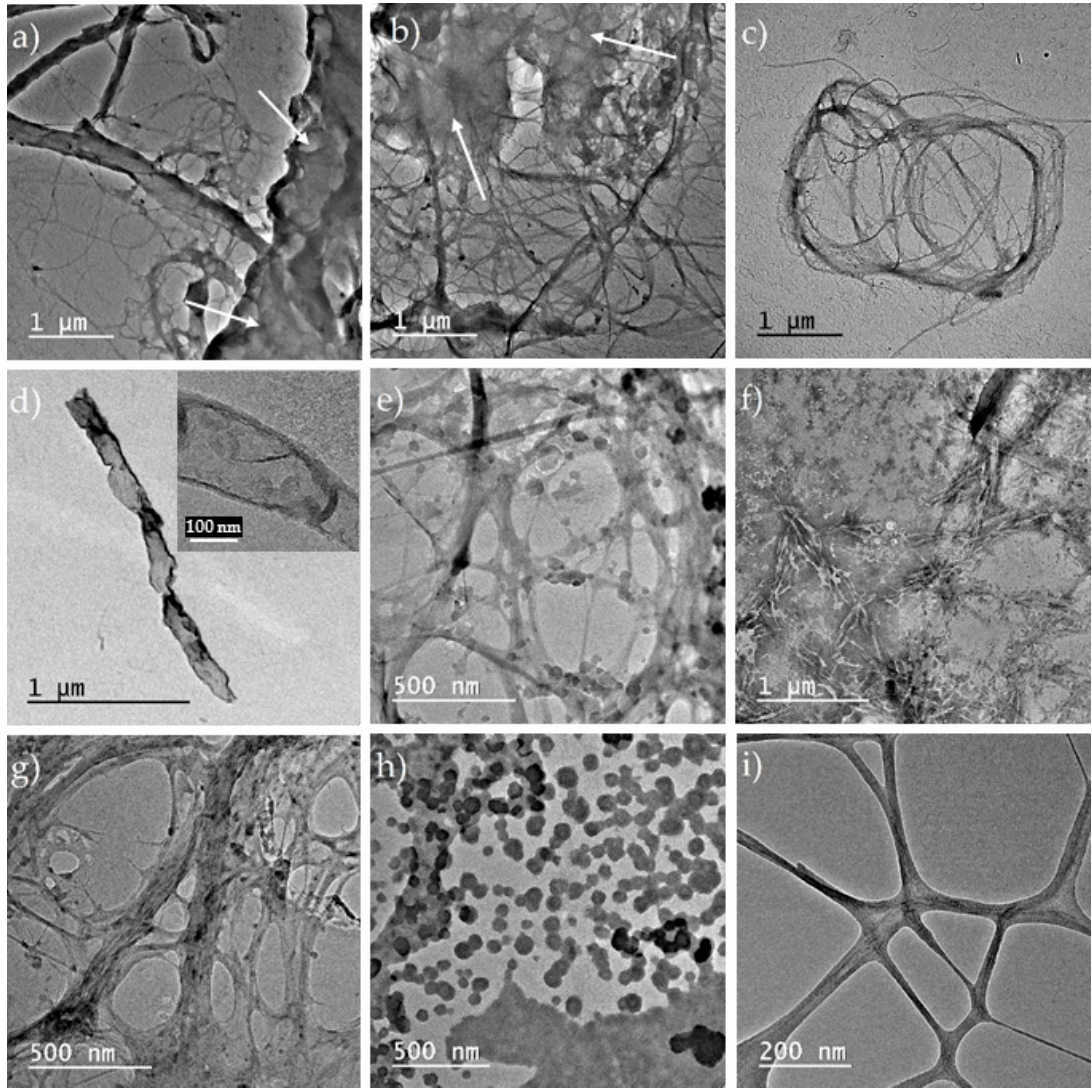
Figure 6. Transmission electron microscopy (TEM) images of cellulose fibrils: ( a ) initial Kombucha membrane (K_0); ( b ) after 1 M NaOH washing (K_1M); ( c , d ) after 4 M NaOH washing and nano-atomization (K_AT); ( e ) after 1 pass through microfluidizer (K_M1P); ( f ) micro-crystalline cellulose after 1 pass (MC_1P); ( g ) K_CM after 10 passes (K_M10P); ( h ) micro-crystalline cellulose after 10 passes (MC_10P); ( i ) K_CM after 25 passes through microfluidizer (K_M25P).